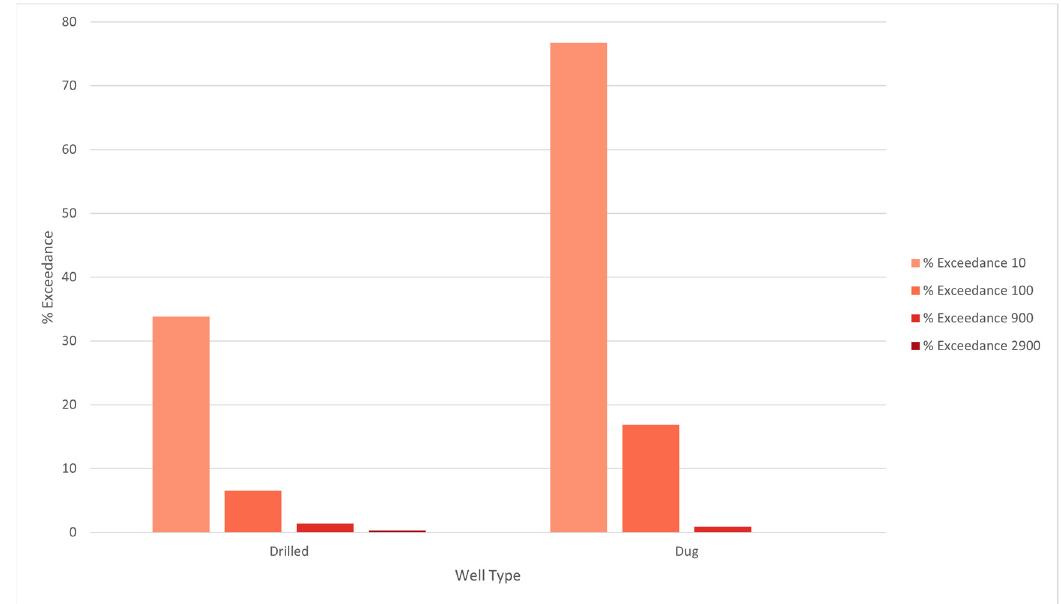
Figure 6. Percentage of samples of each well type that exceed each aluminum threshold (10 µg/L, 100 µg/L, 900 µg/L, and 2900 µg/L).